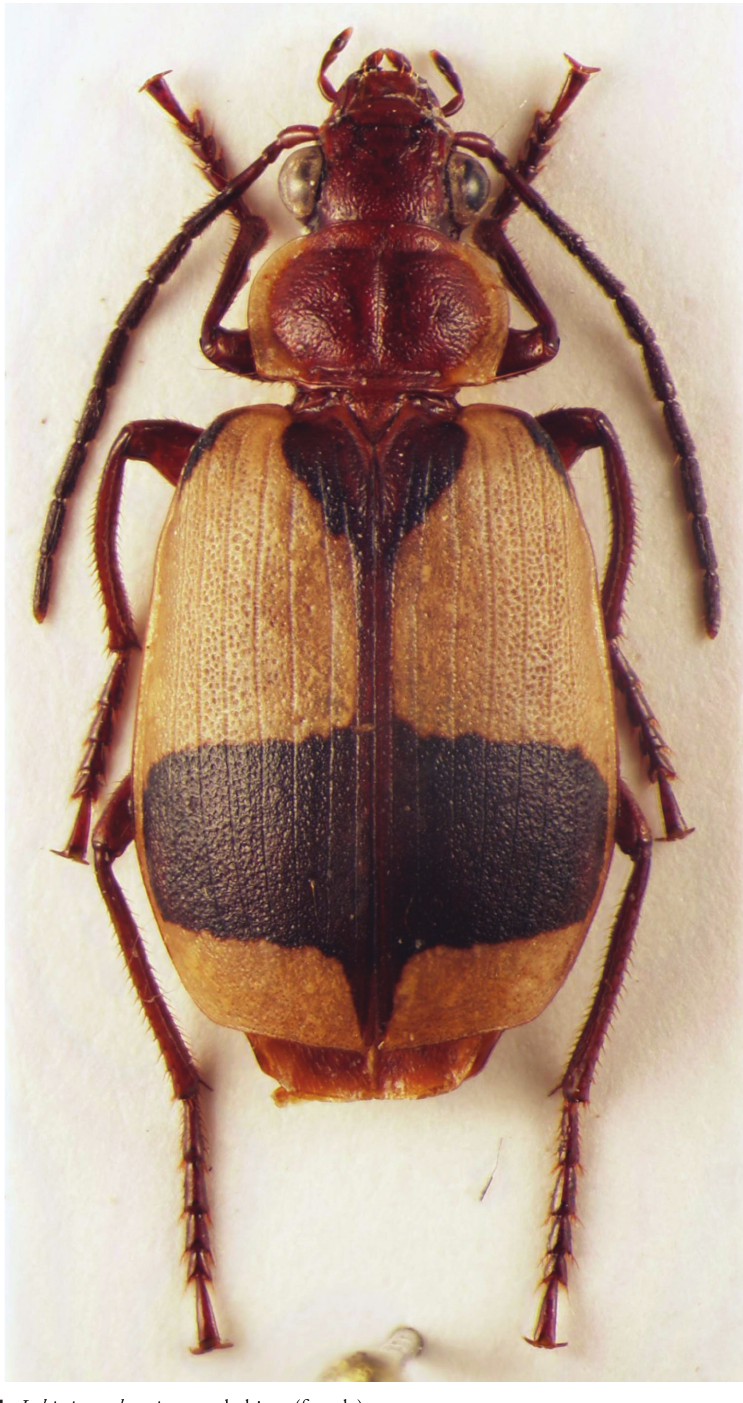
Figure 1. Lebistina rehagei sp. n., habitus